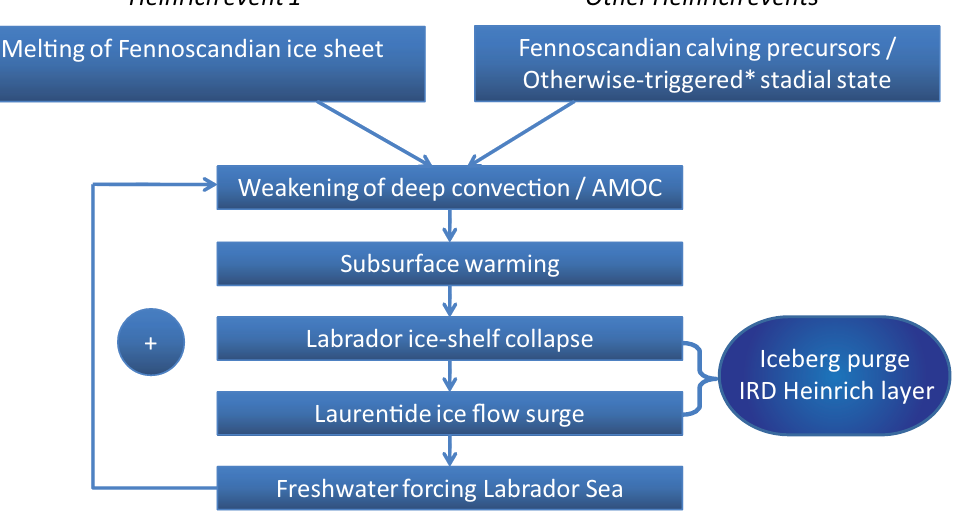
Fig. 5. Schematics of the triggering mechanism of Heinrich events proposed here. *Note that, for H1, an earlier fennoscandian freshwater flux has been identified while fennoscandian precursors are still debated for the other HEs. However, these do not represent a necessary condition for the mechanism suggested